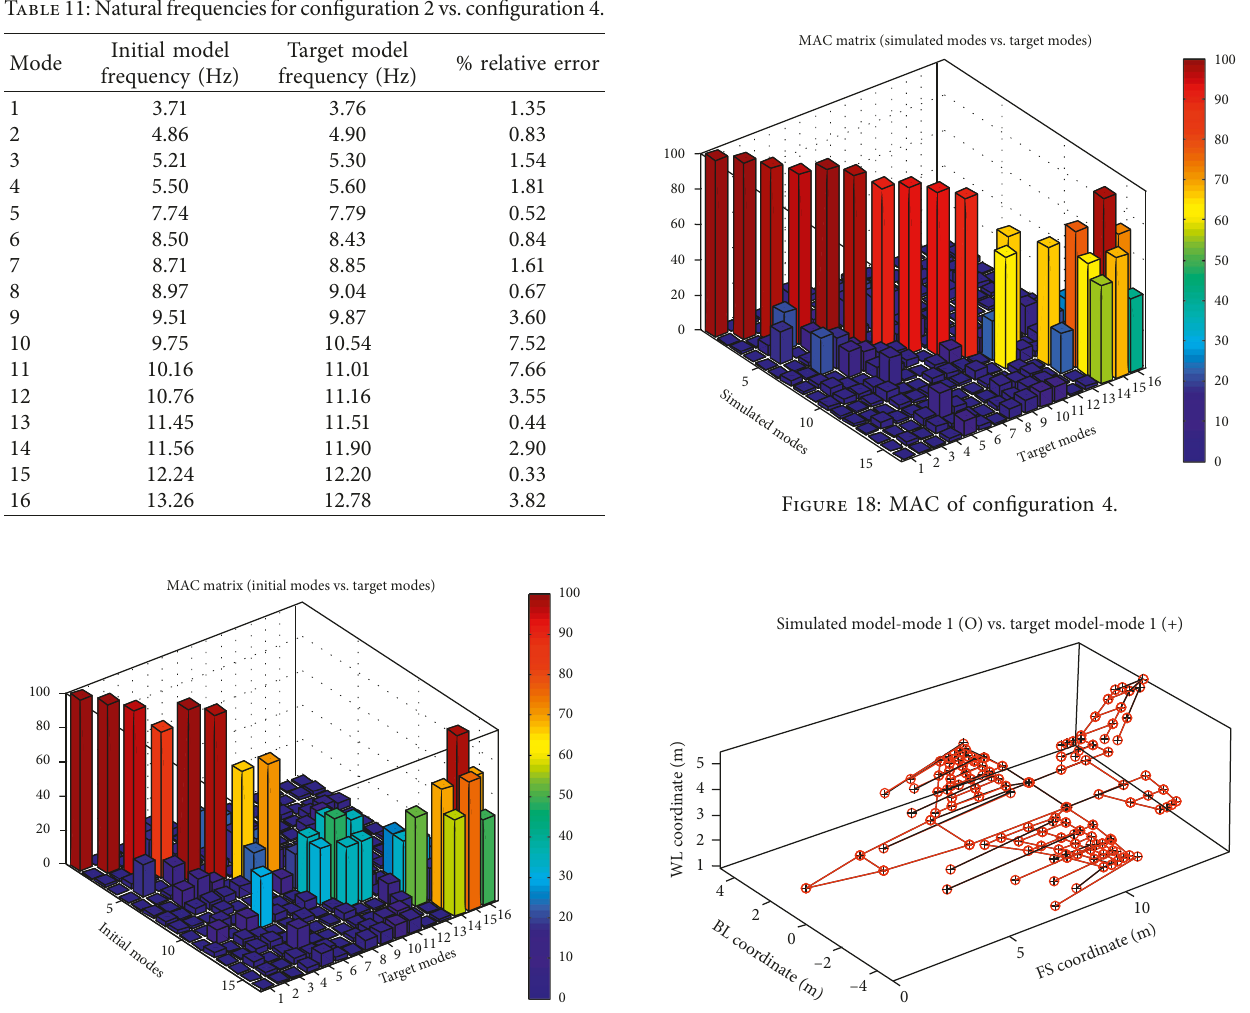
Figure 19: Mode shape for configuration 4